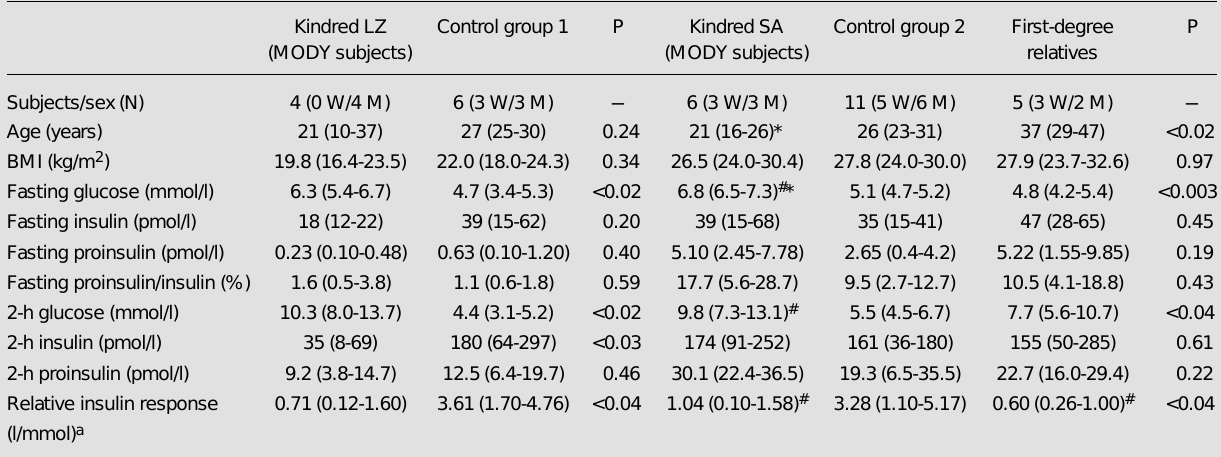
Table 1 - Clinical and metabolic profiles of family members. Data are reported as mean and interquartile range. The Kruskal-Wallis (rank sums) and Tukey-Kramer HSD tests with log-transformed data were used when the results of the Kruskal-Wallis test were significant (P<0.05). # P<0.05 compared to control group 2, and *P<0.05 compared